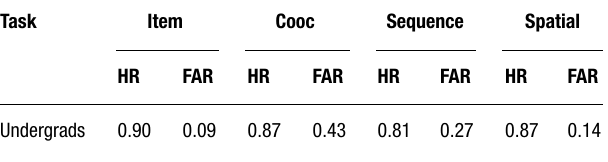
Figure 10 | Performance of college-age participants on each task in Experiment 3, with standard error bars. Table 5 | Hit and false alarm rates for college-age participants on each task in Experiment